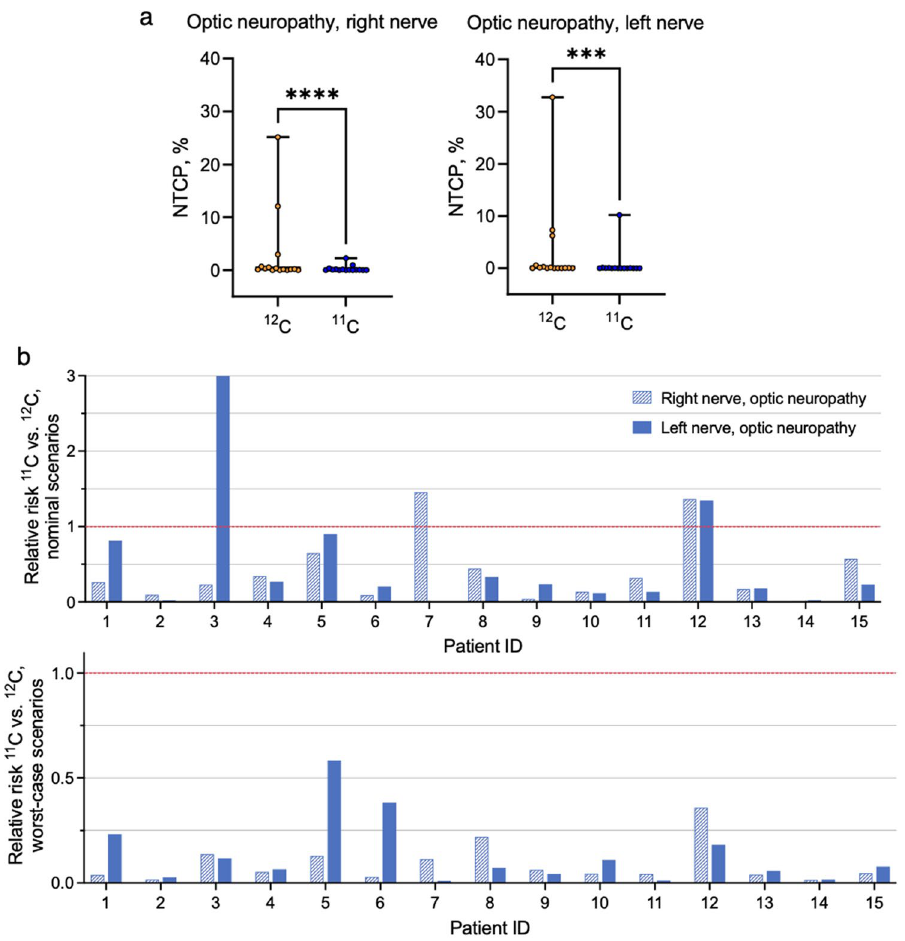
Figure 4. Normal tissue complication probability estimations for ACC patients. ( a ) NTCP (endpoint optic neuropathy) estimated for the right and left optic nerves for each patient using the Lyman-Kutcher-Burman model with parameters from 51 for 12 C and 11 C treatment plans. Single points correspond to the patient-specific median NTCP values. Stars represent the result of the Wilcoxon Signed-Rank test ( P = 0.00006 for the right nerve and P = 0.0003 for the left nerve) for both plots. ( b ) Relative risks (RR) representing the ratio of 11 C versus 12 C NTCP values for individual patients for the right (dashed bar) and left (solid color bars) optic nerves. RR < 1 means that the 11 C plan is beneficial compared to 12 C plan in terms of optic system toxicity. Top: nominal scenarios, bottom: worst-case